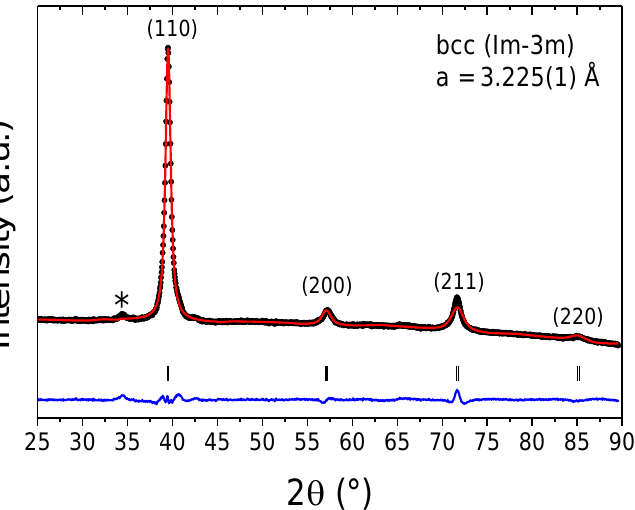
Figure 1. X- ray diffraction pattern (λ = 1.5406 Å ) of the as-cast Ti 0.30 V 0.25 Cr 0.10 Zr 0.10 Nb 0.25 with the cor- responding Rietveld analysis; star symbol indicates a small impurity. The asterisk is indicating the presence of a small unknown impurity.